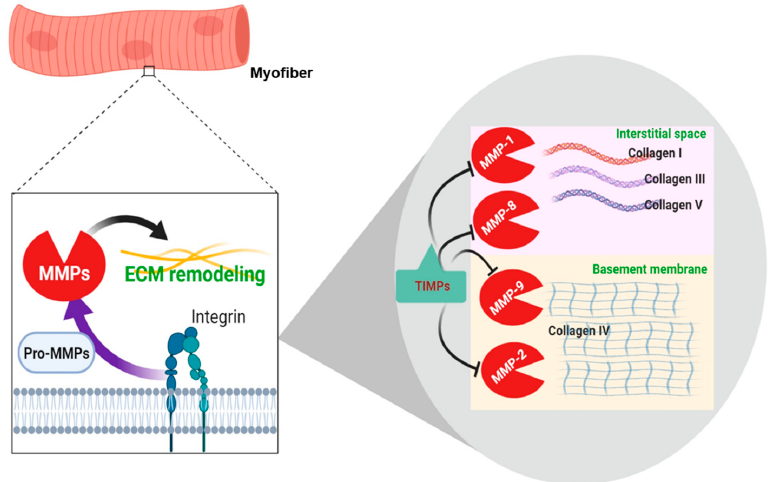
Figure 3. Schematic representation of extracellular matrix (ECM) remodeling in skeletal muscle. 30